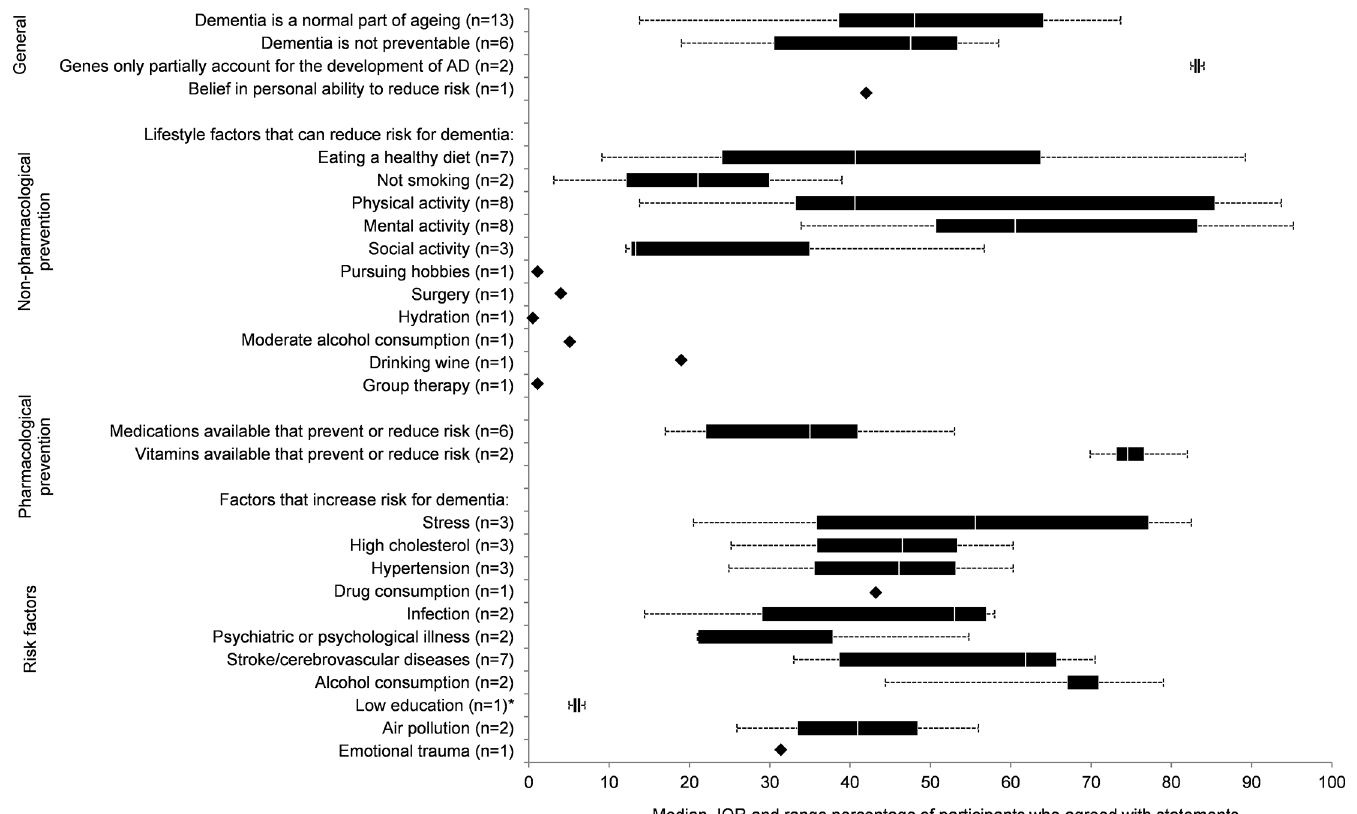
Fig 1. Synthesis of public knowledge and beliefs about prevention of